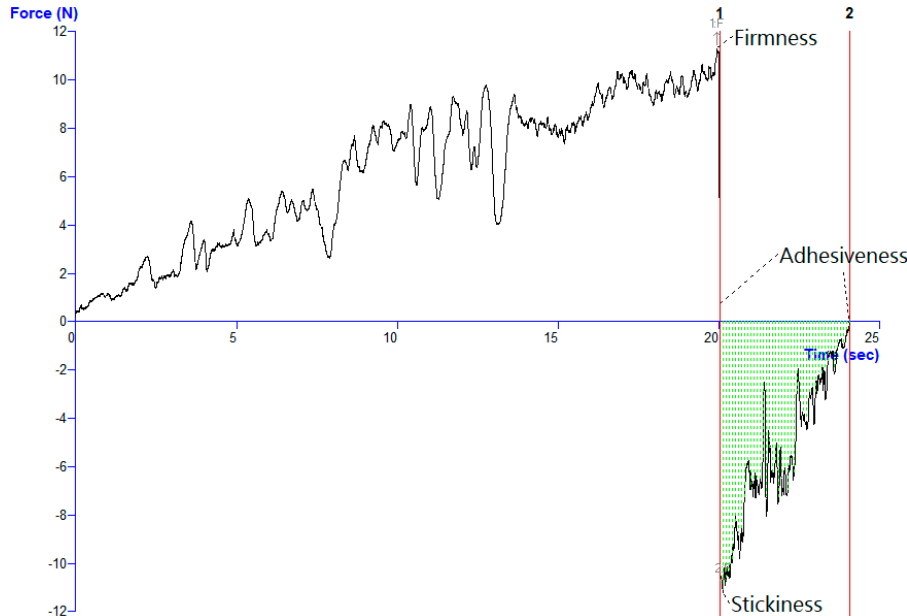
Figure 4. Graph of textural analysis performed to a pasta sample that allows obtaining the textural parameters hardness, adhesiveness and stickiness.